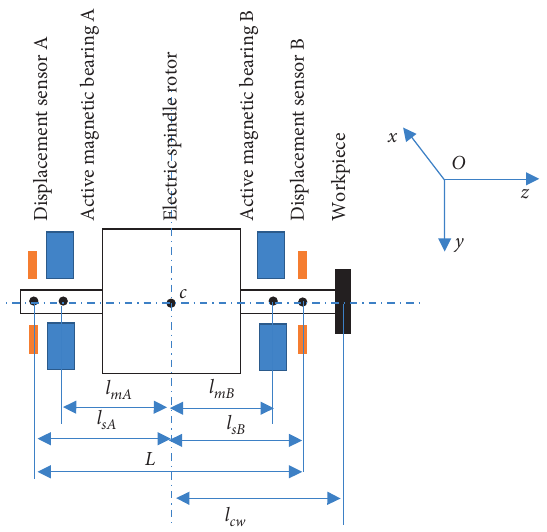
Figure 1: Active magnetic bearing-supported motorized spindle milling